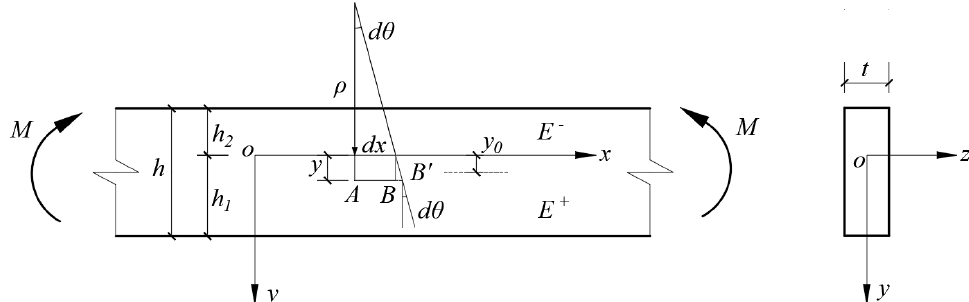
Figure 2. The mechanical model on subarea in tension and compression under mechanical load.